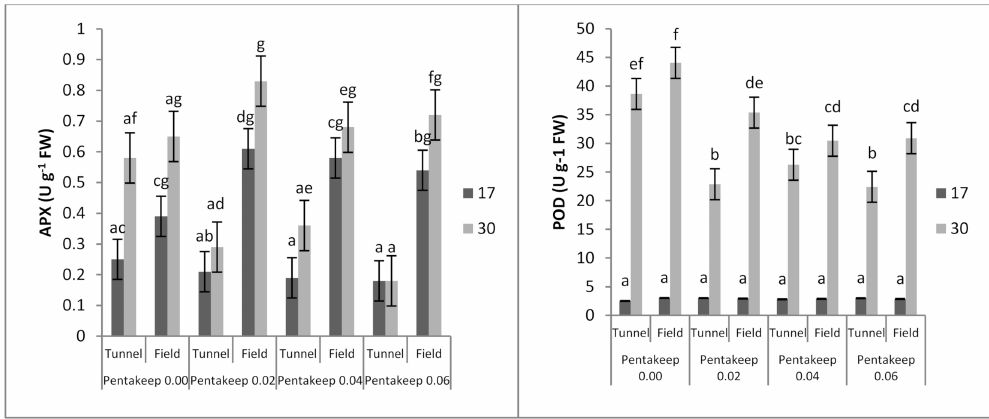
Figure 5. E ff ect of growth conditions (unheated foil tunnel and open field) and foliar treatment (six times during vegetative period) with di ff erent concentrations of Pentakeep V (0.00%, 0.02%, 0.04%, 0.06%) on the activity of ascorbate and guaiacol peroxidases in leaves measured after 17 and 30 days of storage of the P. multiflorum cutfoliage in water. Values are mean ± SE, n = 5. The bars marked with the same letters are not significantly di ff erent at p <